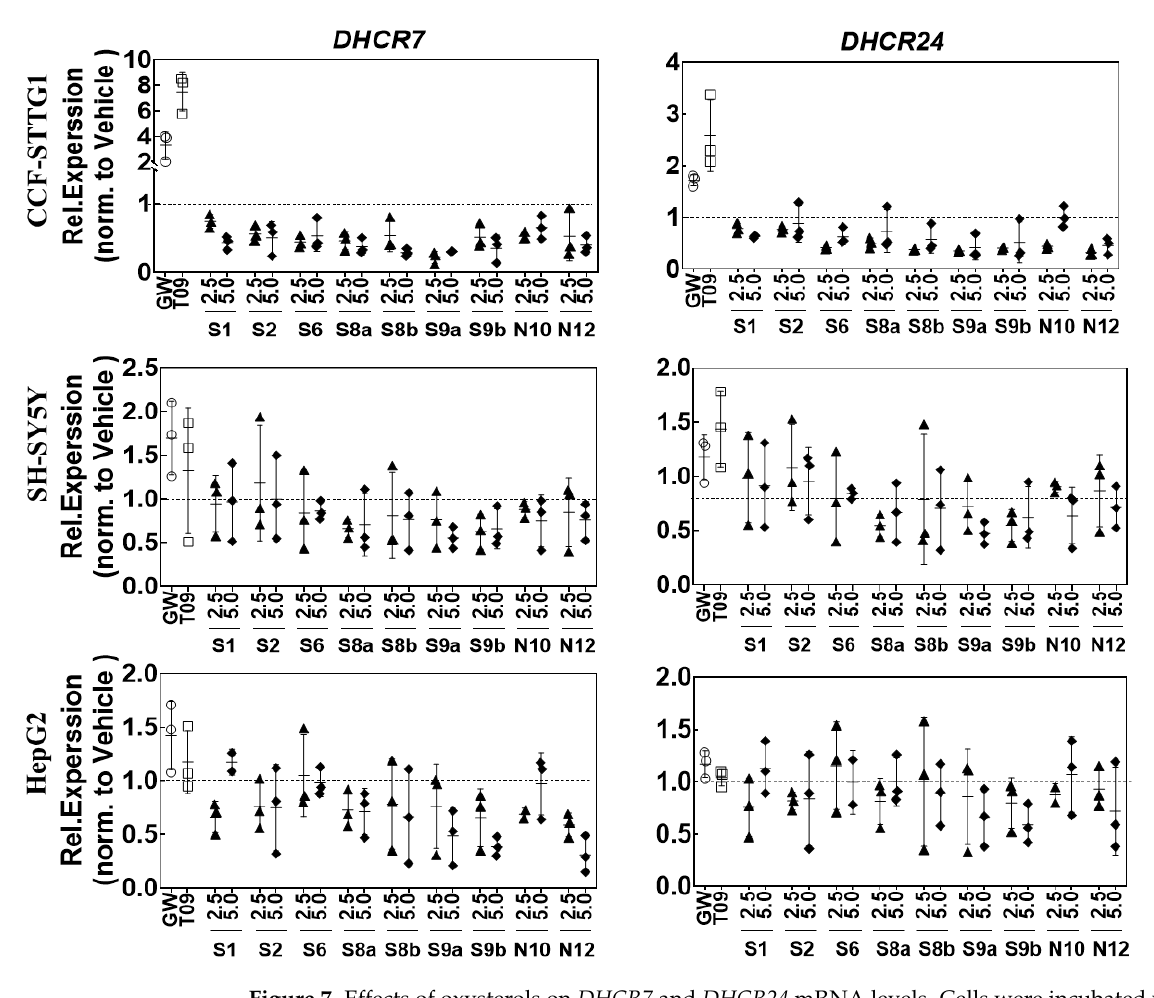
Figure 7. Effects of oxysterols on DHCR7 and DHCR24 mRNA levels. Cells were incubated with 2.5 or 5.0 µ M of 24-oxidized sterols and 1 µ M T0901317 (T09) and 5 µ M GW3965 (GW) for 24 h. Gene expression was determined by qPCR and normalized to the most stable housekeeping genes ( SDHA , B2M , ACTB and HPRT1 ) and expressed as Relative Expression compared to the vehicle control. The values are presented as the means of three experiments ± SD ( n = 3).